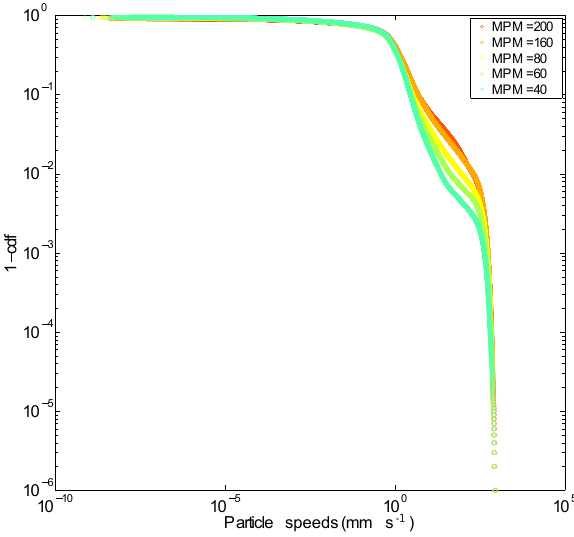
Figure 8. Complementary cumulative distributions of active parti- cle speeds for all experiments. Legend as in Fig. 5.